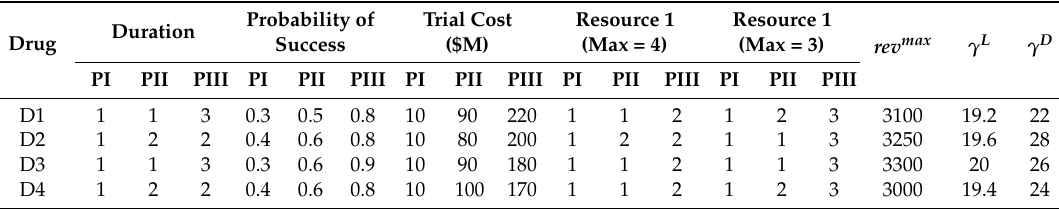
Table A3. Parameters of the four-drug case study.